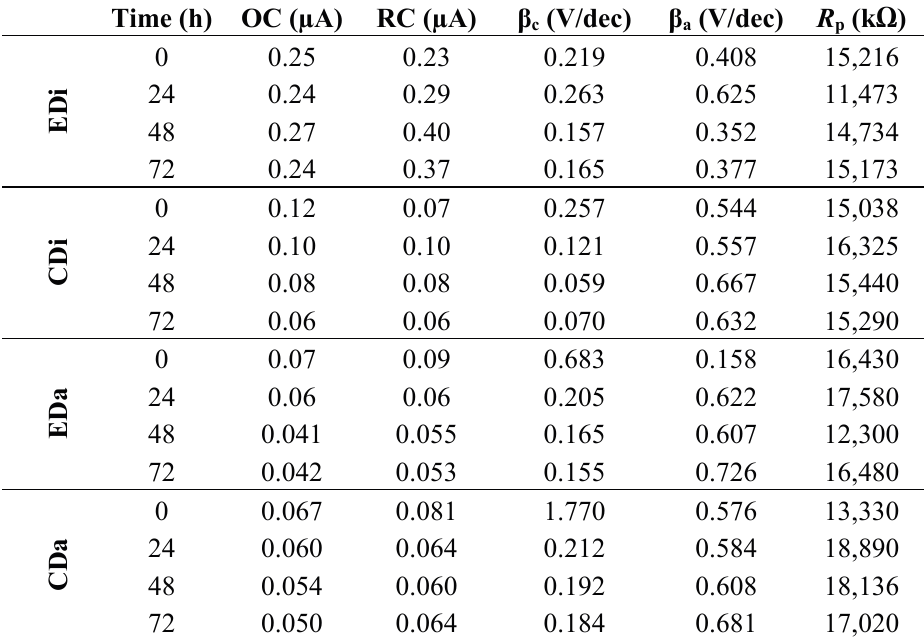
Table 1. Comprehensive results of bioelectrochemical analysis carried out for both the control (DFS) and experimental systems